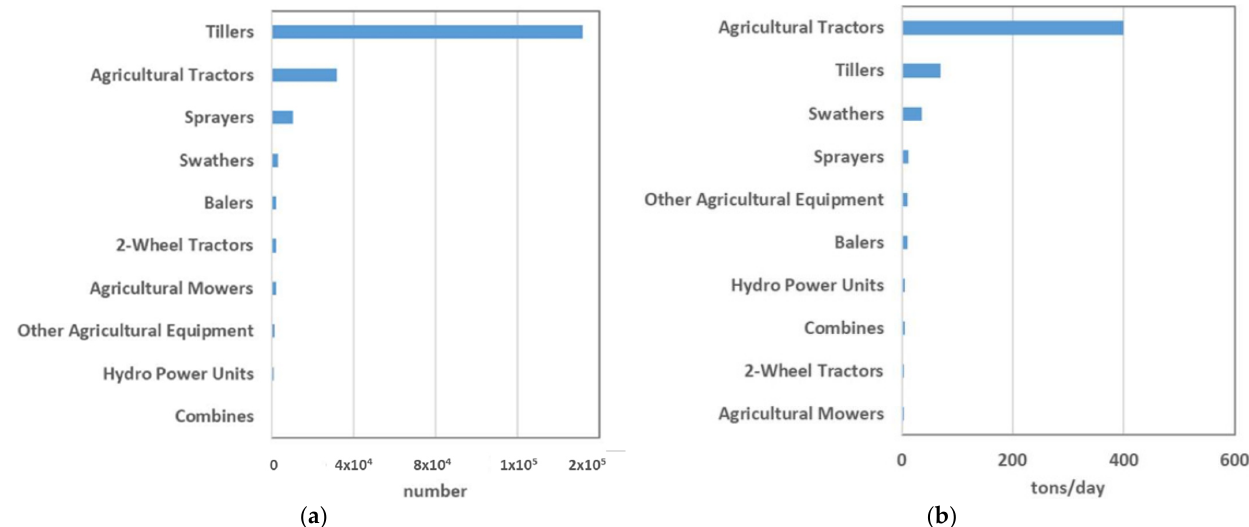
Figure 7. ( a ) Population and ( b ) CO 2 emission of various agricultural equipment types in California in 2018 (adapted from [24]).